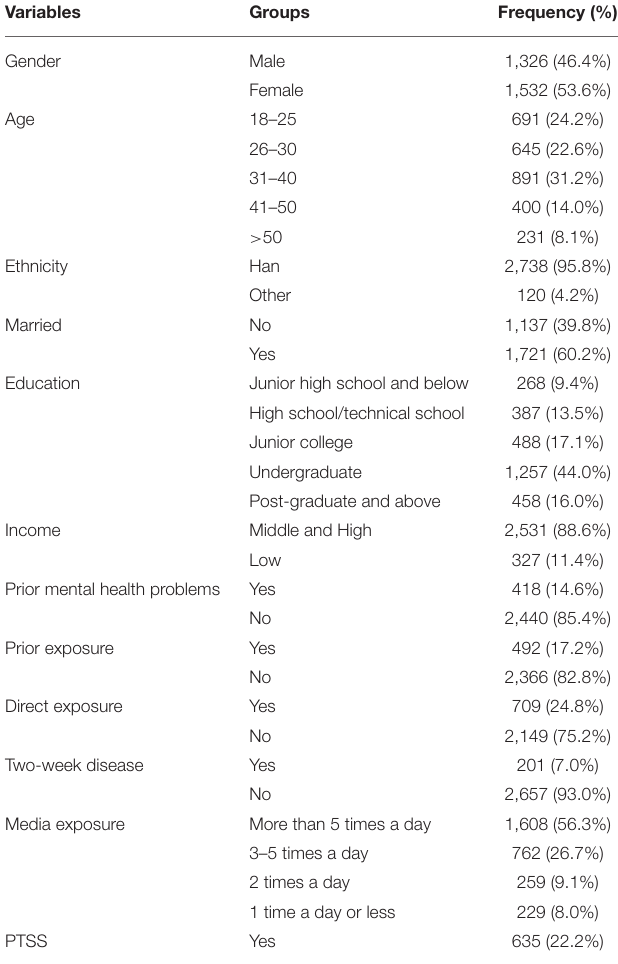
TABLE 2 | Descriptive data on sociodemographics, media exposure, and PTSS.